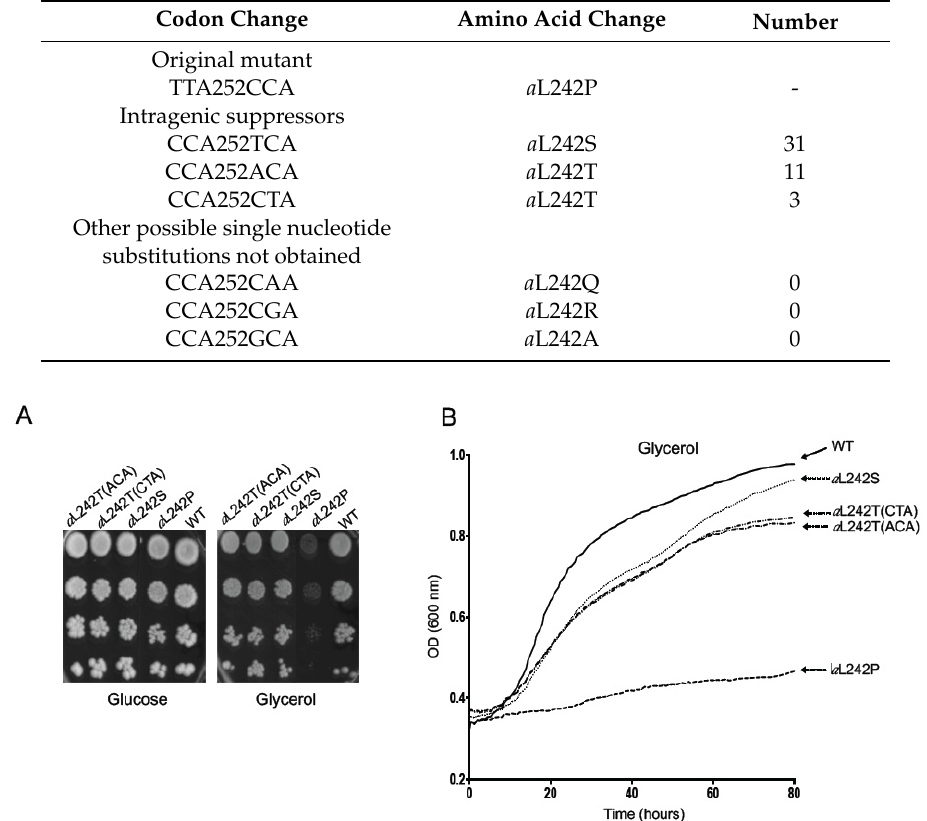
Table 1. Intragenic suppressors of a L242P.